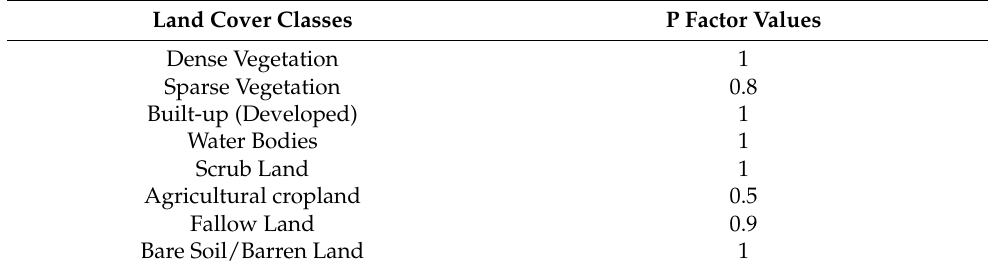
Table 3. Land cover classes and their respective P factor values.